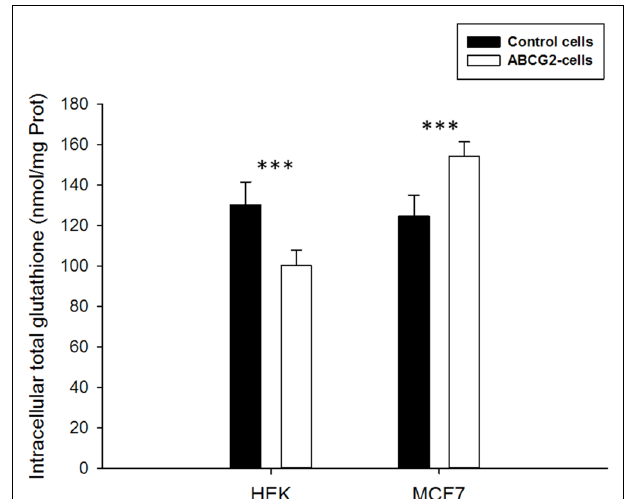
FIGURE 1 | Basal total intracellular glutathione levels in HEK293 or MCF7 cells. The values of either ABCG2-overexpressing cells (white bars) or control cells (black bars) represent means ± SD corresponding to at least three independent experiments performed in triplicates.The differences observed between both cell line pairs were significantly different. t -test analysis: *** p <